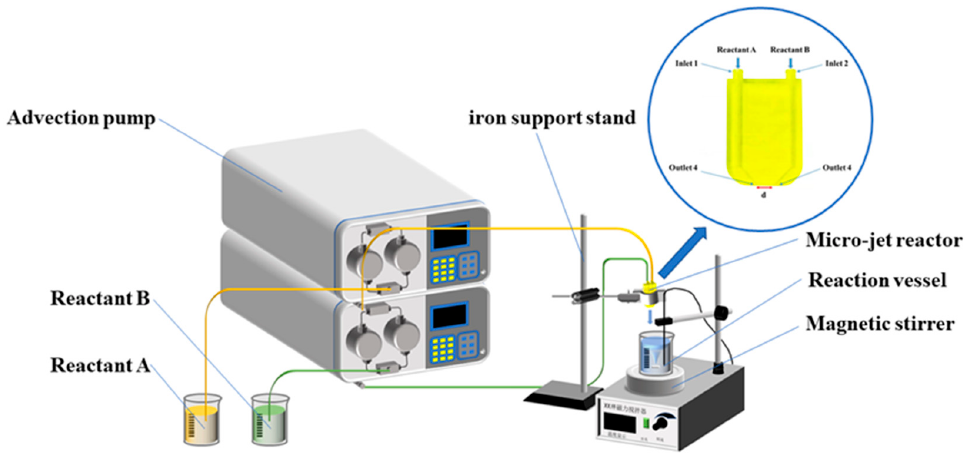
Figure 1. Schematic flow diagram of the reaction device.